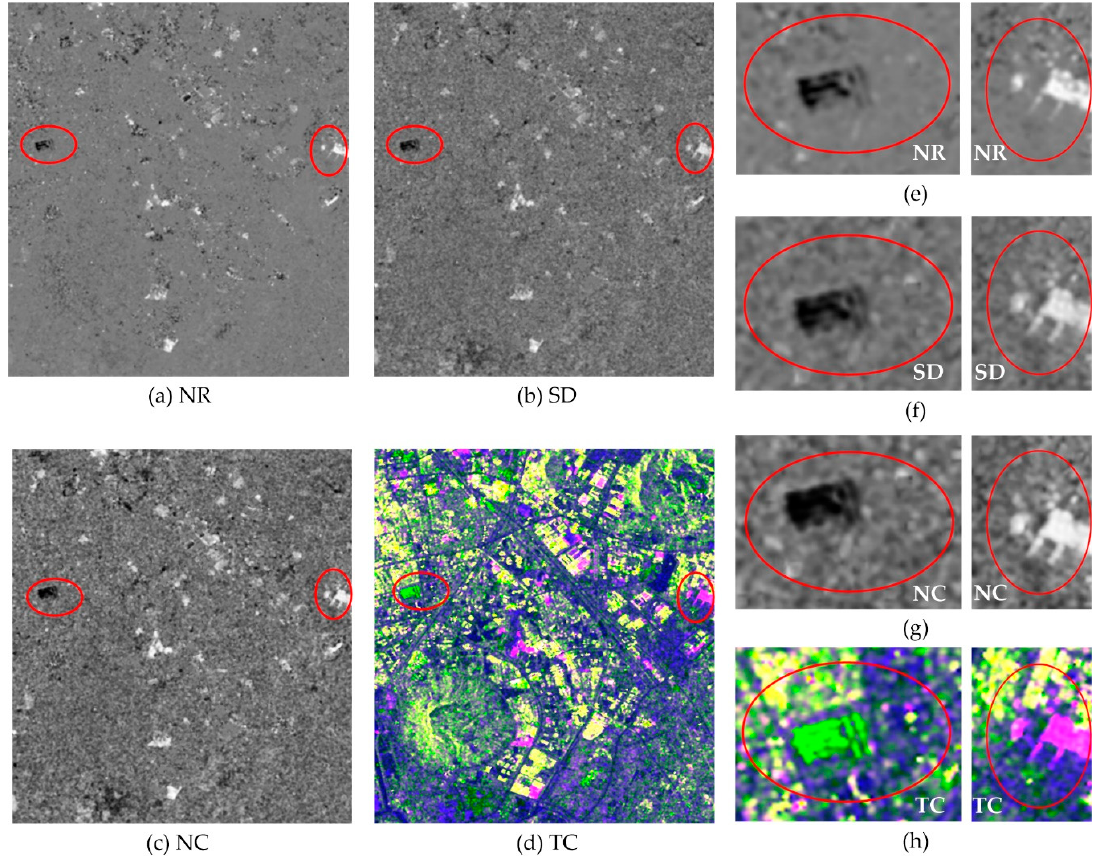
Figure 5. The illustration of the four difference images by using bitemporal SAR image patches in Jiangning District. The two right columns show details of these difference images; ( e – f ) correspond to ( a – d ).